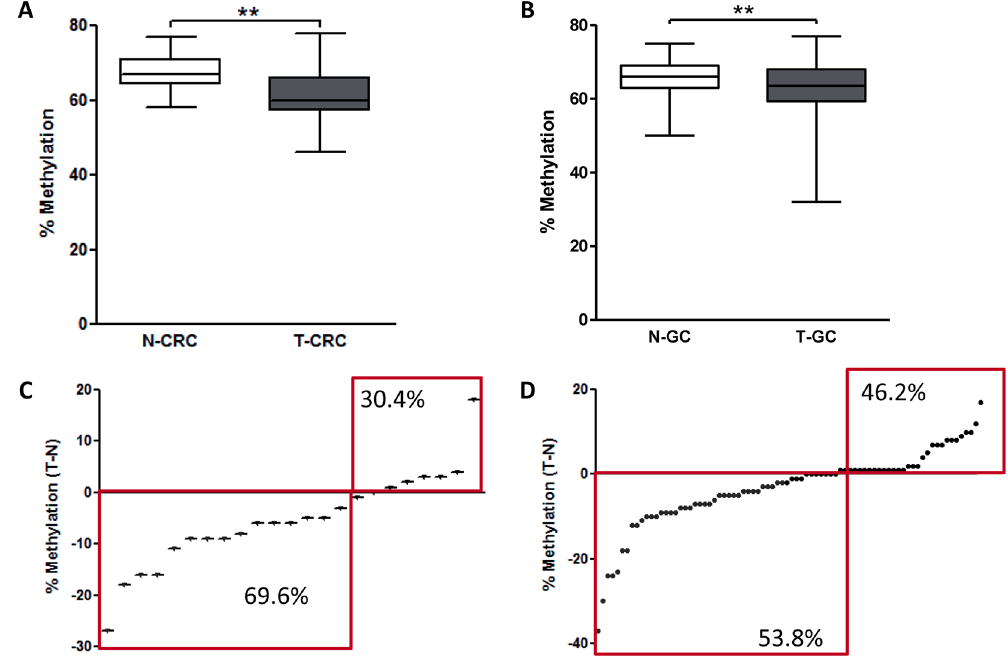
Figure 1. Quantitative LINE-1 methylation analyses in paired colorectal (CRC) and gastric cancer (GC) tissues. ( A ) LINE-1 methylation in paired T-CRC and adjacent N-CRC tissues (n = 24) (p = 0.0005). ( B ) LINE-1 methylation level in T-GC and adjacent N-GC tissues (n = 80) (p = 0.002). ( C and D ) Absolute difference between LINE-1 methylation in matching ( C ) T-CRC and N-CRC, and ( D ) T-GC and N-GC tissues. Wilcoxon test has been used for paired analyses ** P <